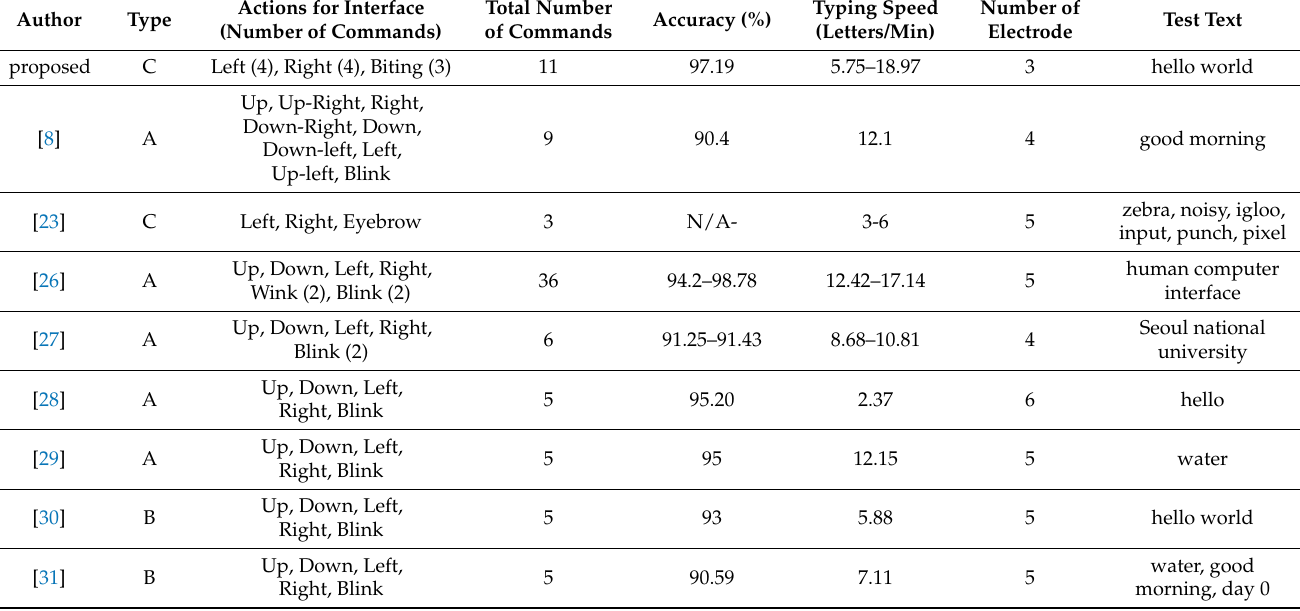
Table 4. Comparison of EOG-based virtual keyboard interfaces with those in previous